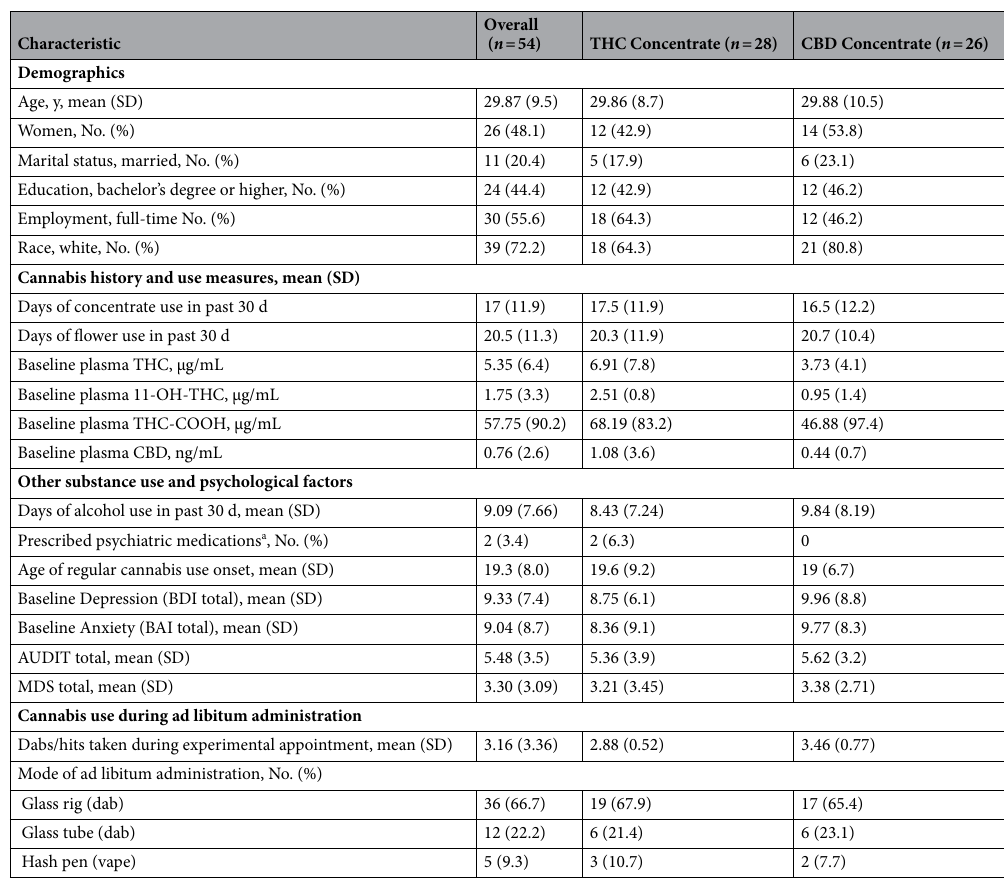
Table 1. Sample demographic, cannabis use, and other health characteristics by overall sample and concentrate assignment. a The 2 participants (2.5%) endorsing psychiatric medications reported taking prescriptions for attention-deficit/ hyperactivity disorder (ADHD). No significant differences were found to exist between conditions in any measure.